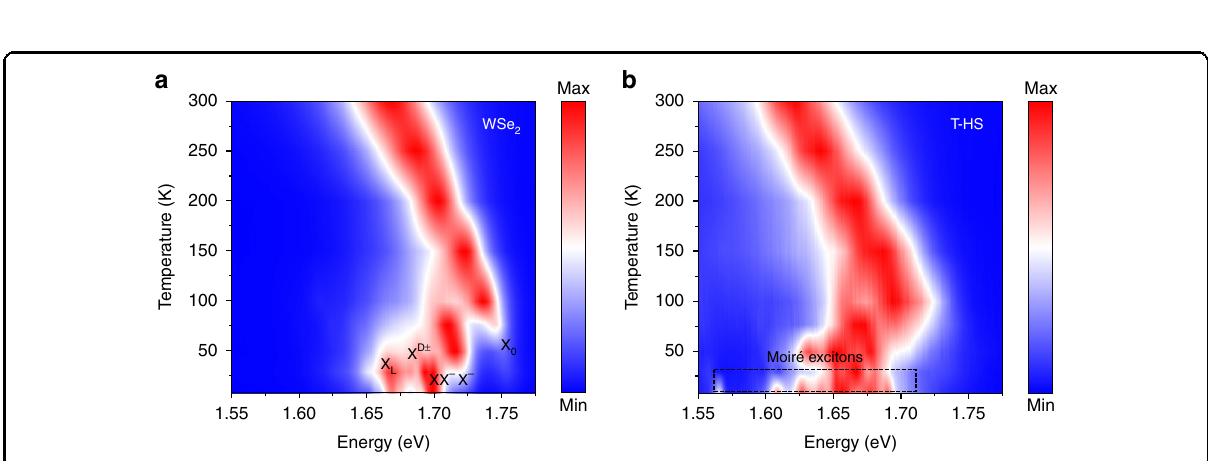
Fig. 2 Temperature-dependent PL spectra of WSe 2 /WSe 2 twisted homobilayer. a The normalized PL spectra of monolayer WSe 2 versus temperature (8 K~300 K). As the temperature decreases, the PL spectrum shows a blue shift, and the types of excitons become more complicated. The energies from high to low are neutral exciton, charged exciton, charged biexciton, dark exciton, and local exciton. b The normalized PL spectrum of T-HB varies with temperature, from 8 K to 300 K. At 8 K, the PL spectrum of the T-HB region showed many small split peaks different from the exciton peaks of the monolayer WSe 2 exciton peaks, indicating that the moiré exciton peaks formed by the trapping of intralayer excitons are affected by the moiré